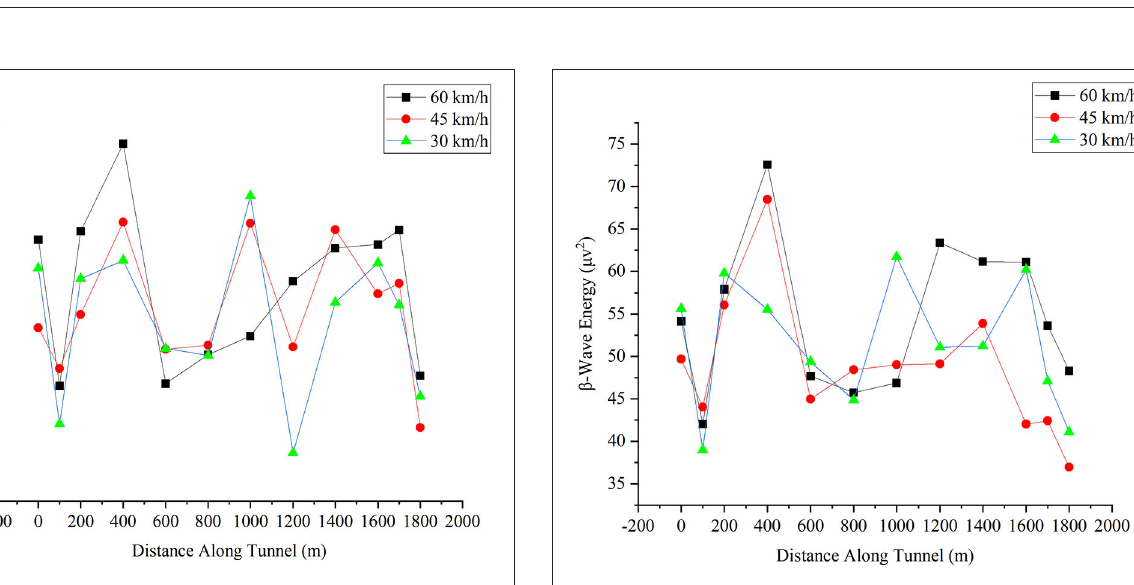
FIGURE 6 | Change in α -wave energy in the frontal lobe for different driving speeds.